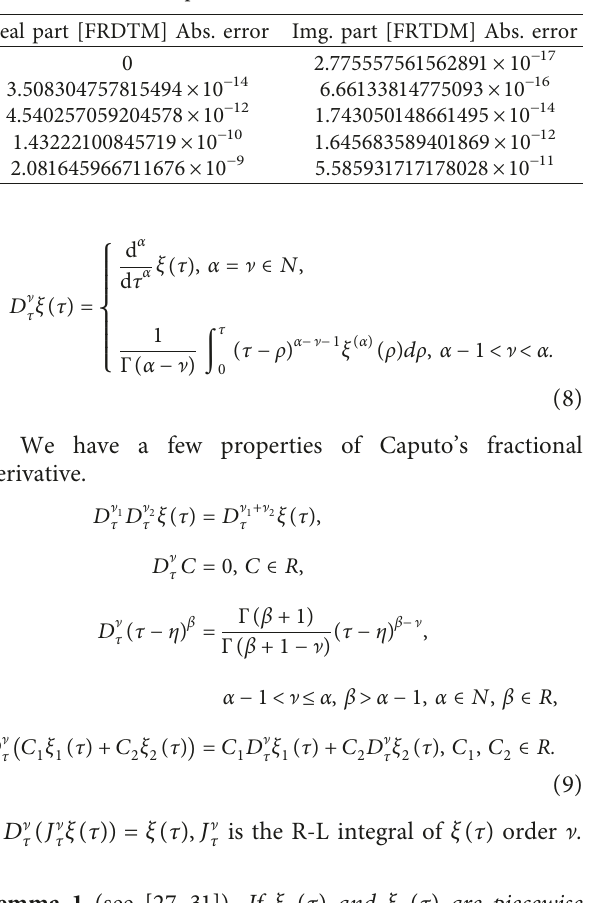
Table 1: The absolute error in ATDM and FRDTM for Example 1 at ] �